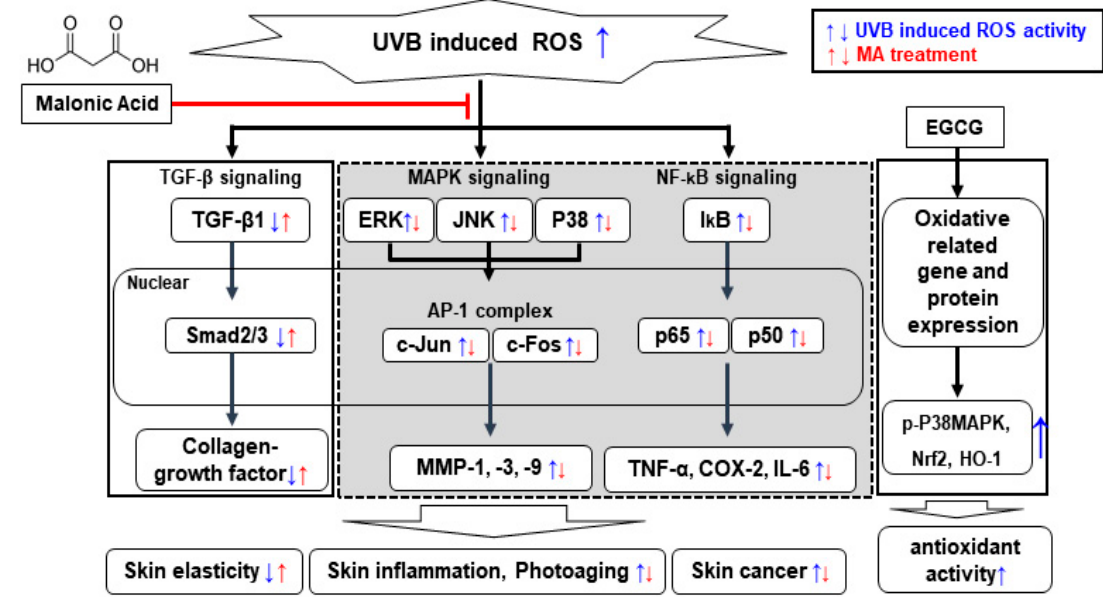
Figure 6. A schematic model of malonic acid (MA) inhibiting ultraviolet (UV) B-induced reactive oxygen species (ROS) activity . MA inhibits UVB-induced ROS in skin cells and suppresses mitogen-activated protein kinase (MAPK) and nuclear factor (NF)- κ B signaling pathways through the reduced activity of the MAPK/activator protein 1 (AP-1) complex, matrix metalloproteinase (MMP) expression, and NF- κ B activity. In addition, the transforming growth factor (TGF)- β /Smad signaling pathway is increased to promote collagen production. These results suggest MA inhibits skin inflammation and photoaging. (Blue arrow: ROS induced signaling without MA treatment, Red arrow: ROS signaling with MA treatment).